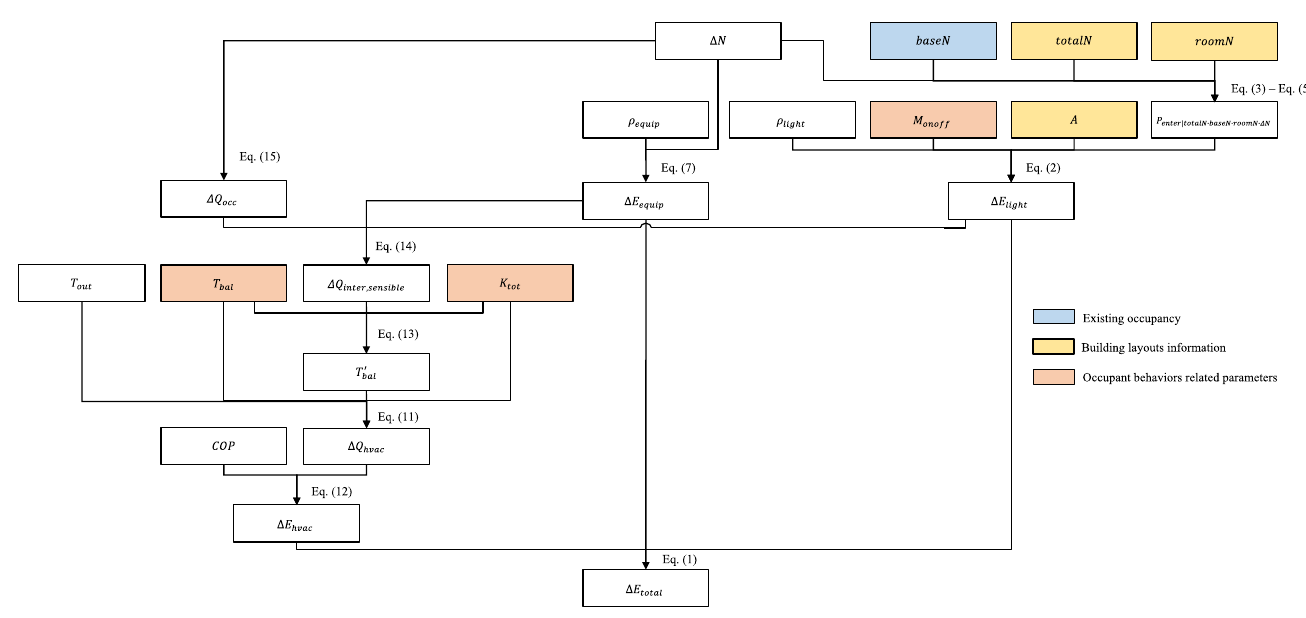
Figure 3. Basic structure of the proposed method.